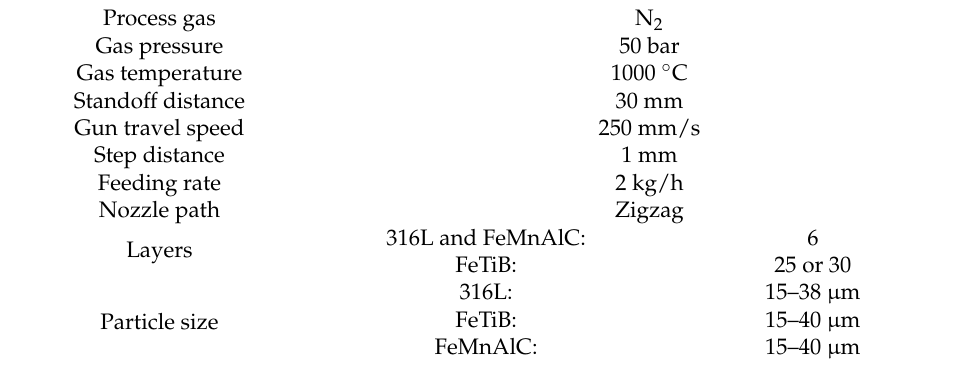
Table 2. Cold gas spraying